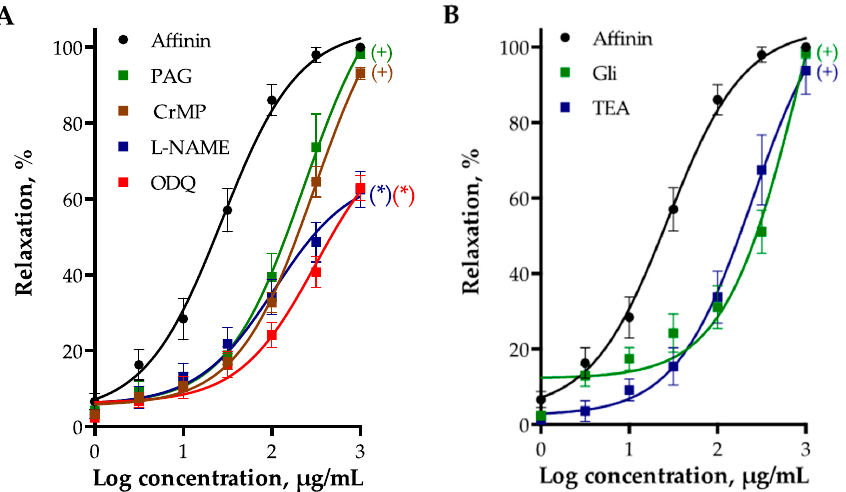
Figure 4. ( A ) Vasodilator effect of affinin in the absence (control) and presence of PAG (1